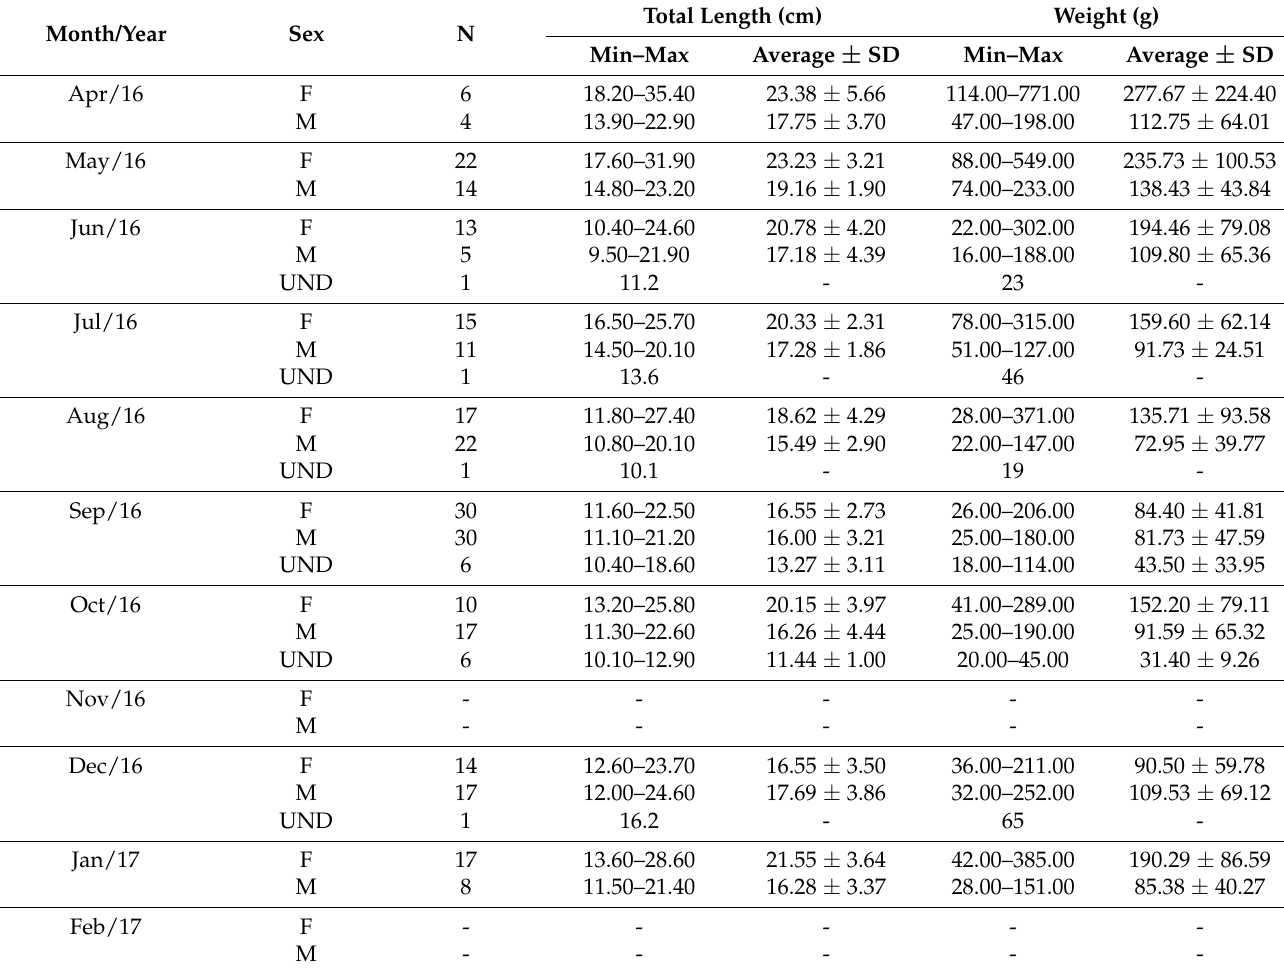
Table 1. Variation in total length (cm) and weight (g) of Genyatremus luteus specimens collected from April/16 to April/17 on the Ajuruteua peninsula, Bragança, Par á . Min: minimum, max: